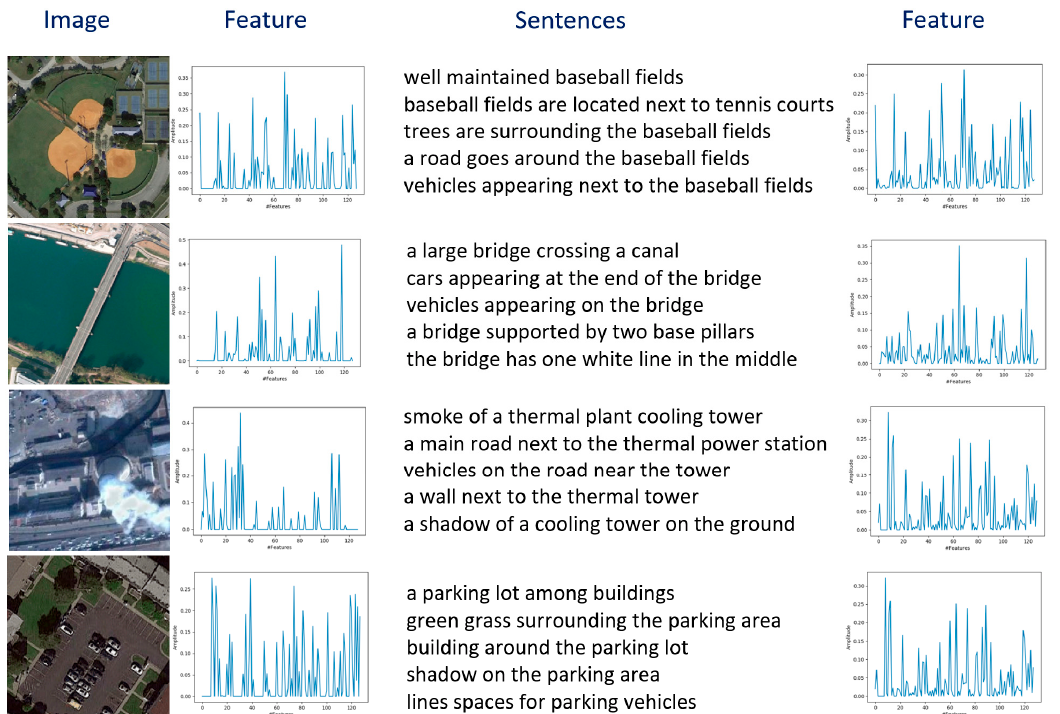
Figure 8. Image and text feature generated by the image and text encoding branches.